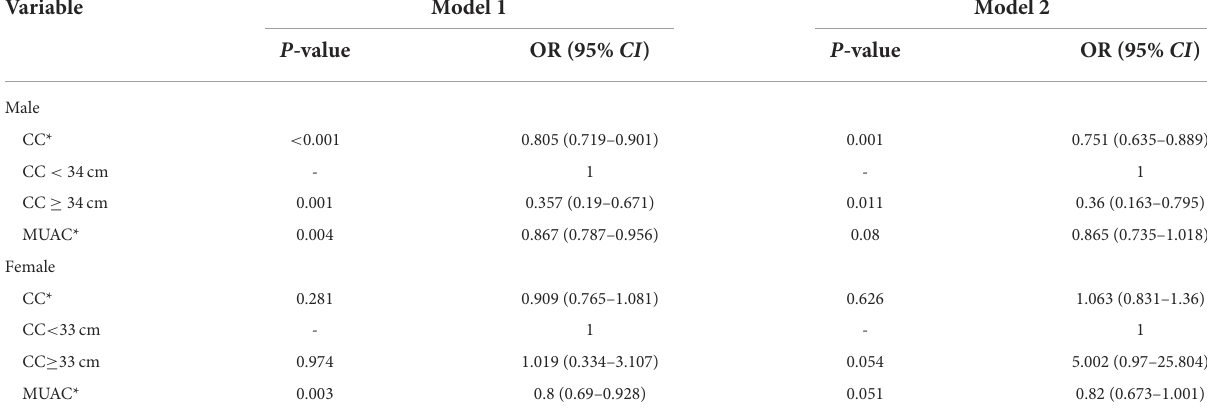
TABLE 3 Correlations between CC, MUAC and pneumonia.